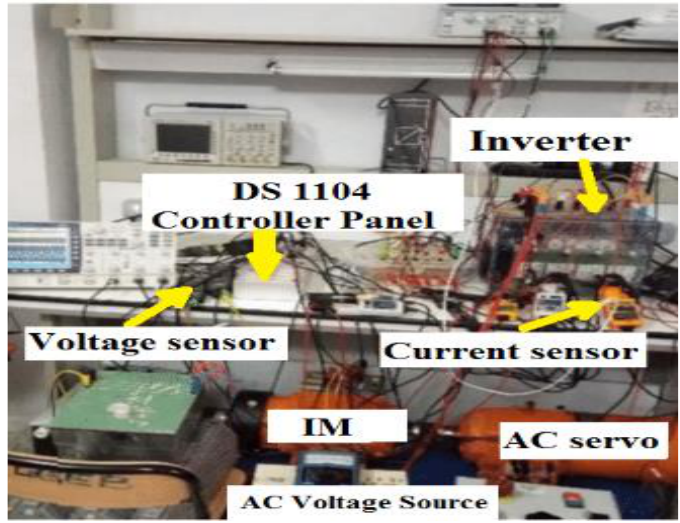
Figure 28. Photo of the hardware setup of the system.